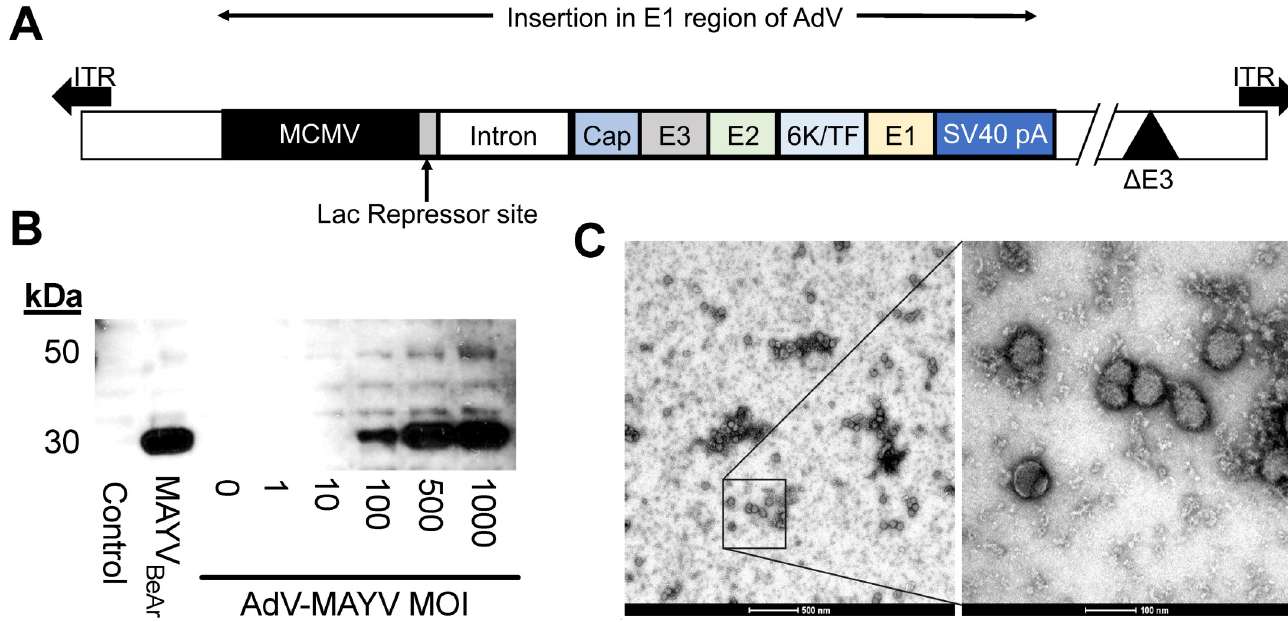
Fig 1. AdV-MAYV Vaccine Vector Expression of MAYV Structural Proteins. (A) The full length MAYV structural protein ORF was inserted into the replication defective huAdV expression vector under the control of the MCMV-IE2 promoter containing a Lac repressor to specifically modulate expression during reconstitution and stock production of the virus. (B) AdV-MAYV expression of the structural protein was evaluated in THF-CAR cells infected with increasing MOIs. Cell lysates were analyzed at 72 hpi for capsid expression by western blotting for the viral capsid protein. Shown is a representative image of two independent experiments. (C) Electron microscopy image of 4% PFA fixed AdV-MAYV VLPs from clarified supernatants of AdV-MAYV infected THF-CAR cells (MOI = 100 PFU/cell). Representative images are shown of 500 nm (left) and 100 nm (right) magnifications. Shown is a representative image of three biological